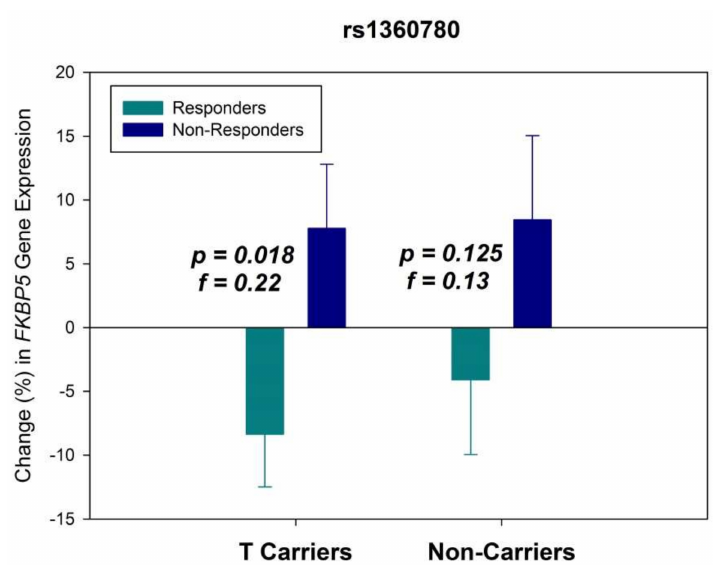
Figure 2. Change (% from baseline) in FKBP5 gene expression at the RNA level after six weeks of antidepressant treatment in responders and non-responders for patients carrying the minor T allele of rs1360780 and for noncarriers. Means ± SEM are